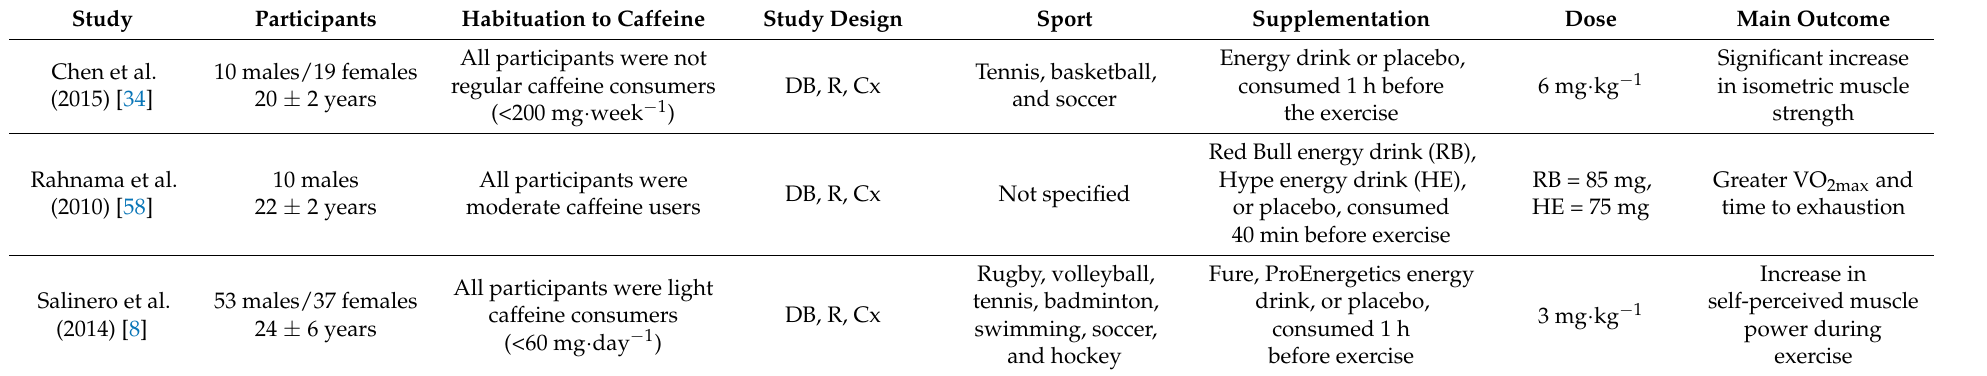
Table A6. Investigations in multiple